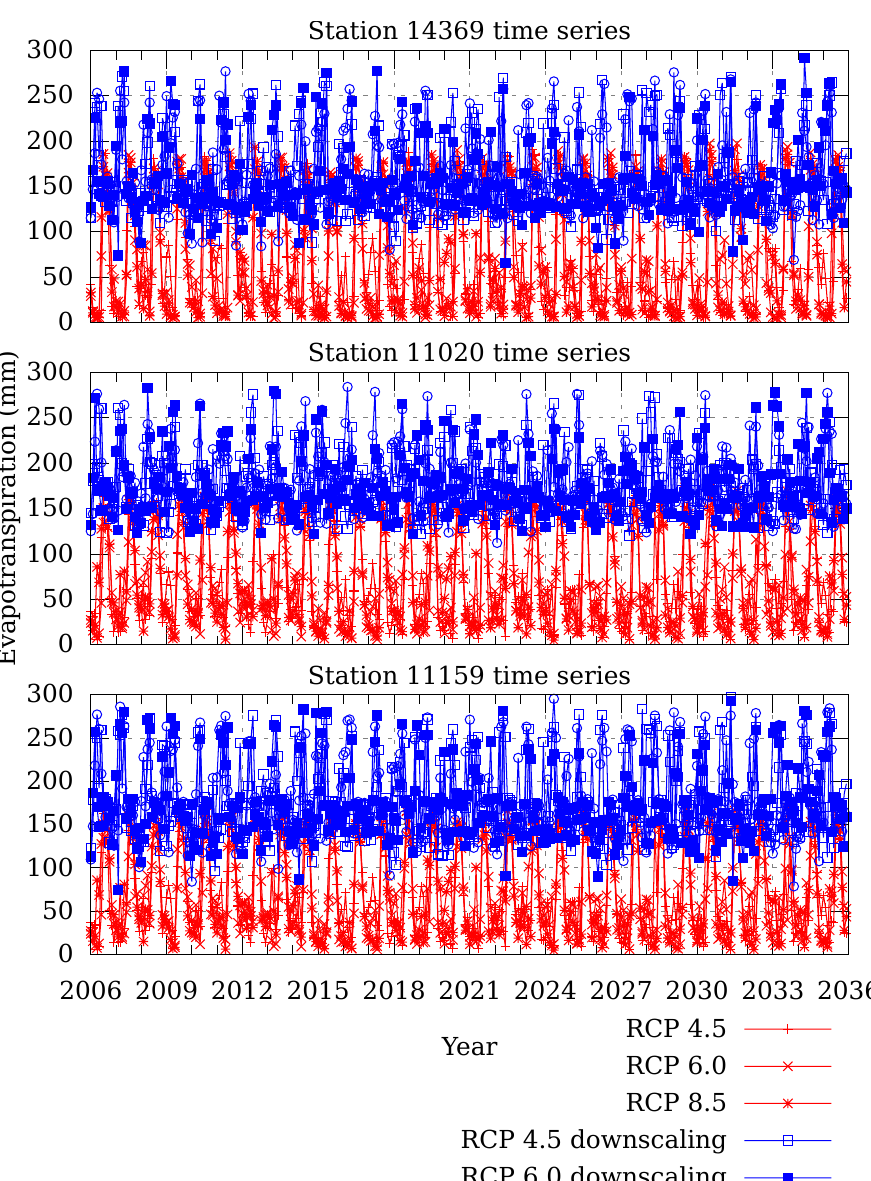
Figure 9. Projected evapotranspiration using ANNs and the CSIRO-Mk3-6-0